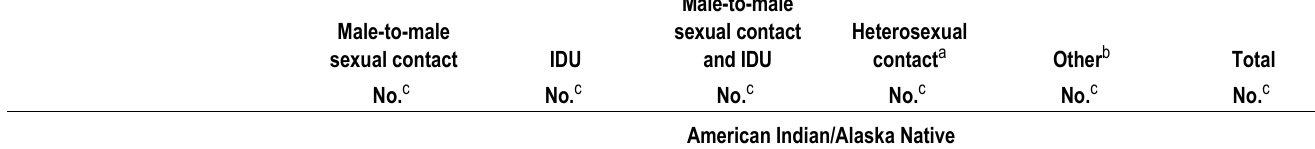
Table 5b. Diagnoses of HIV infection, by transmission category, race/ethnicity, and selected characteristics, 2015—United States and 6 dependent